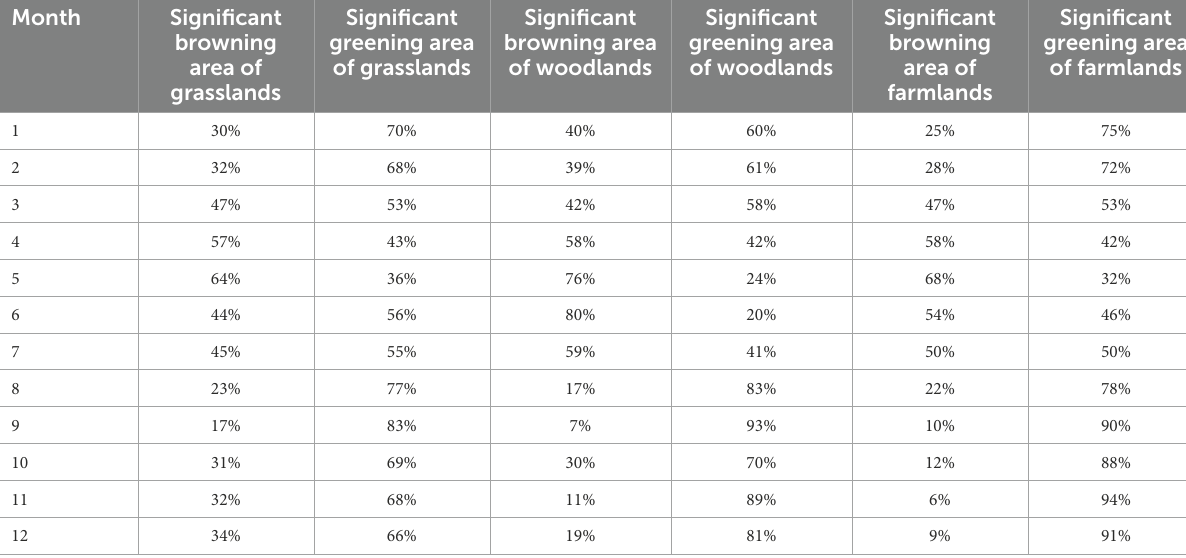
TABLE 3 Significant change of global ecosystems NDVI from 1981 to